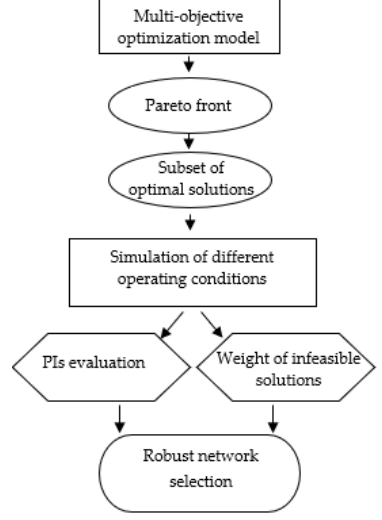
Figure 1. Flowchart of the methodology.